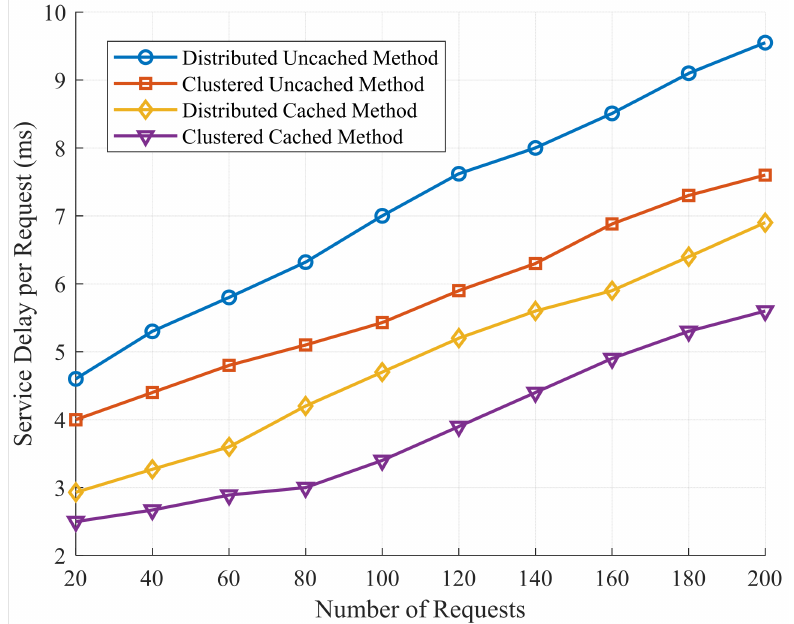
Figure 3. Service Delay for Various MS